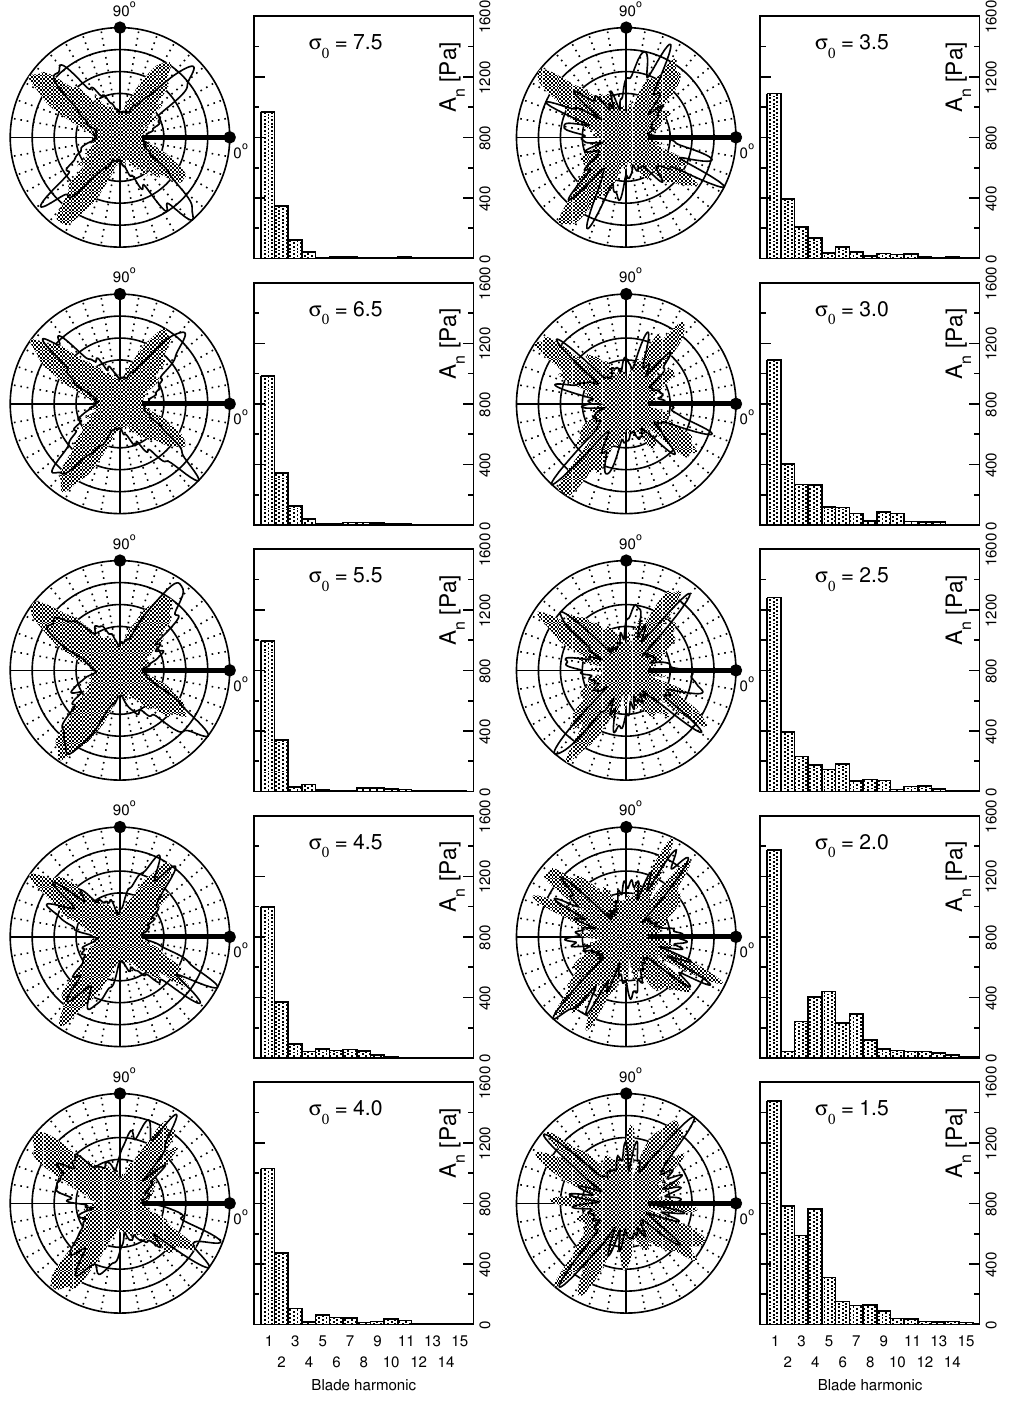
Figure 9. Angular history of the pressure signal from hydrophone H 2 and corresponding harmonic distribution, for different values of the cavitation number σ 0 . The polar graphs are non-dimensionalized. Grey area: ensemble mean; solid line: ensemble